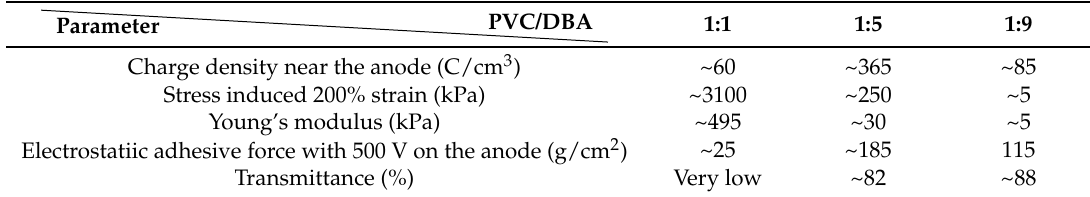
Table 1. Key parameters of PVC gel with different DBA concentrations.